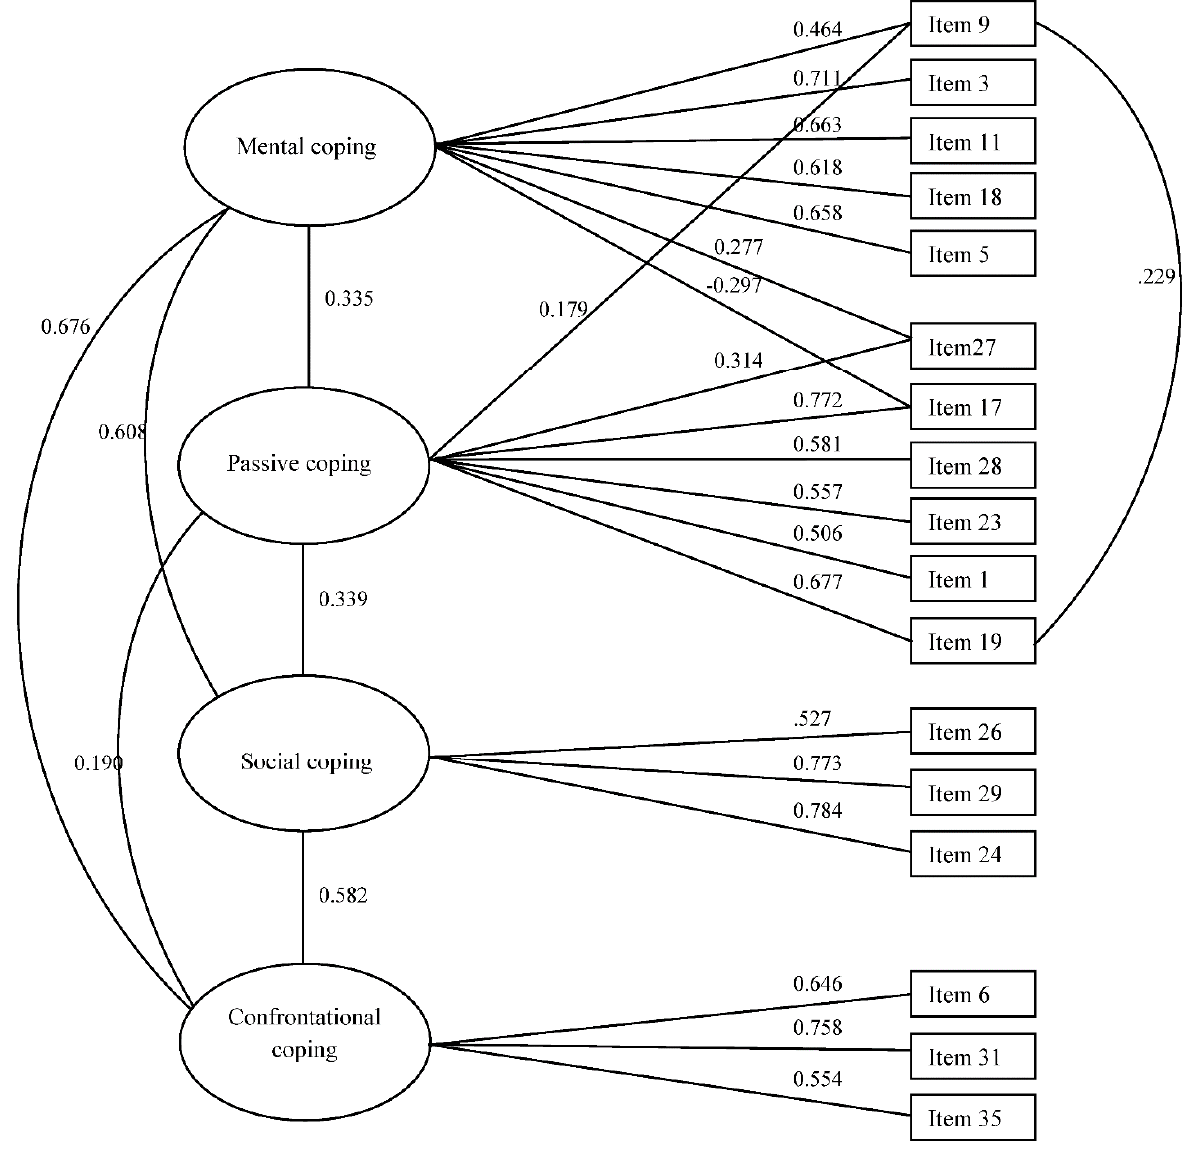
Figure 1. The final model displaying the factor structure of the Cyberbullying Coping Questionnaire including factor